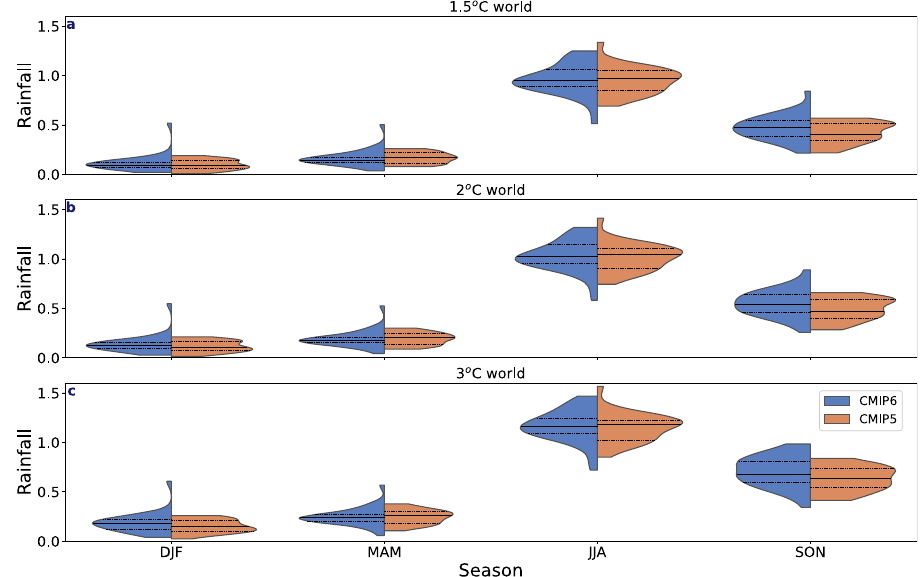
Fig. 7 Arctic rainfall changes per season relative to global warming scenarios. The Arctic rainfall change in mm day − 1 with respect to 1.5 °C, 2 °C and 3 °C global warming for CMIP6 (blue) and CMIP5 (orange) in December – February (DJF), March – May (MAM), June – August (JJA) and September – November (SON). Dashed black lines show the 25 – 75th percentiles and the solid black lines show the multi-model (Fig. 9d), indicating a more rapid loss of snowfall in CMIP6. By snowfall ratio in CMIP6 at the start of the century (Fig. 9b).